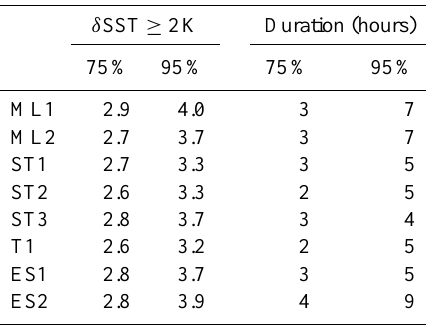
Table 4. Percentiles of δ SST ≥ 2K and its duration (in hours), for the different domains. δ SST ≥